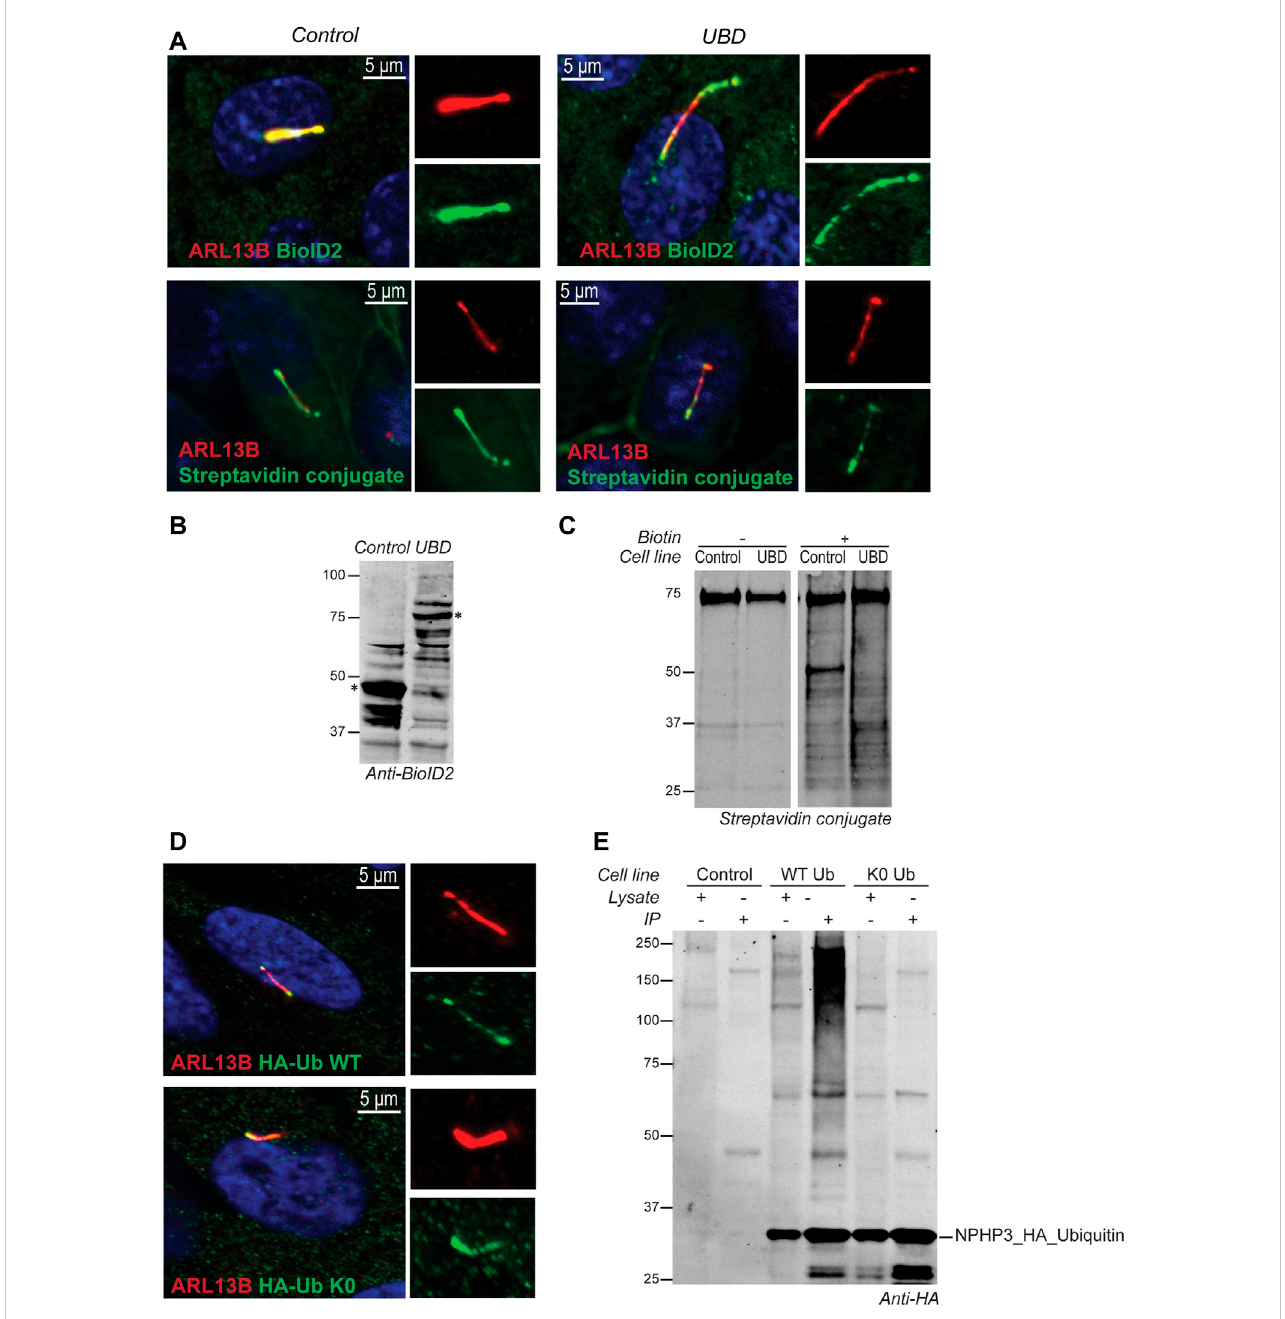
Validation of model systems to study the ciliary ubiquitinome. (A) IF localization of the UBD and empty vector control BioID2 constructs in stable IMCD3 Flp-In cells. Both proteins colocalized with ARL13B (red) at the primary cilium when co-stained with an antibody against the BioID2 tag (green; upper panels).Uponinitiationofproximitylabeling,biotinylatedsubstratescanbedetectedinthecilium(red)usingaconjugated Streptavidinantibody(green;lower panels). (B) A western blot stained with anti-BioID2 was used to verify correct expression of both constructs in whole cell extracts of IMCD3 Flp-In cells. (C) Immunoprecipitation upon addition of biotin showed a ladder of biotinylated proximal targets in both control and UBD cells when labeled with a conjugated Streptavidin antibody. (D) IF analysis of stably transfected RPE1 cells con fi rmed that both the wild type ubiquitin (HA-Ub WT), as well as the ubiquitinationimpairedmutant(HA-UbK0)detectedusingananti-HAstaining(green)colocalizedwithARL13B(red)attheprimarycilium. (E) Immunoblotting usingananti-HAantibodyindicatedthatbothubiquitinvariantswereexpressedcorrectlycomparedtountransfectedcontrol cells.Therecombinantproteins and their respective interactors could successfully be puri fi ed from lysates by immunoprecipitation. Furthermore, as expected, the immunoprecipitated HA- Ub WT also showed a characteristic smear of ubiquitinated substrates at high molecular weight which was not observed for the ubiquitination impaired HA- Ub K0 mutant demonstrating that polyubiquitin chain formation is not impeded in the HA-Ub WT cells.